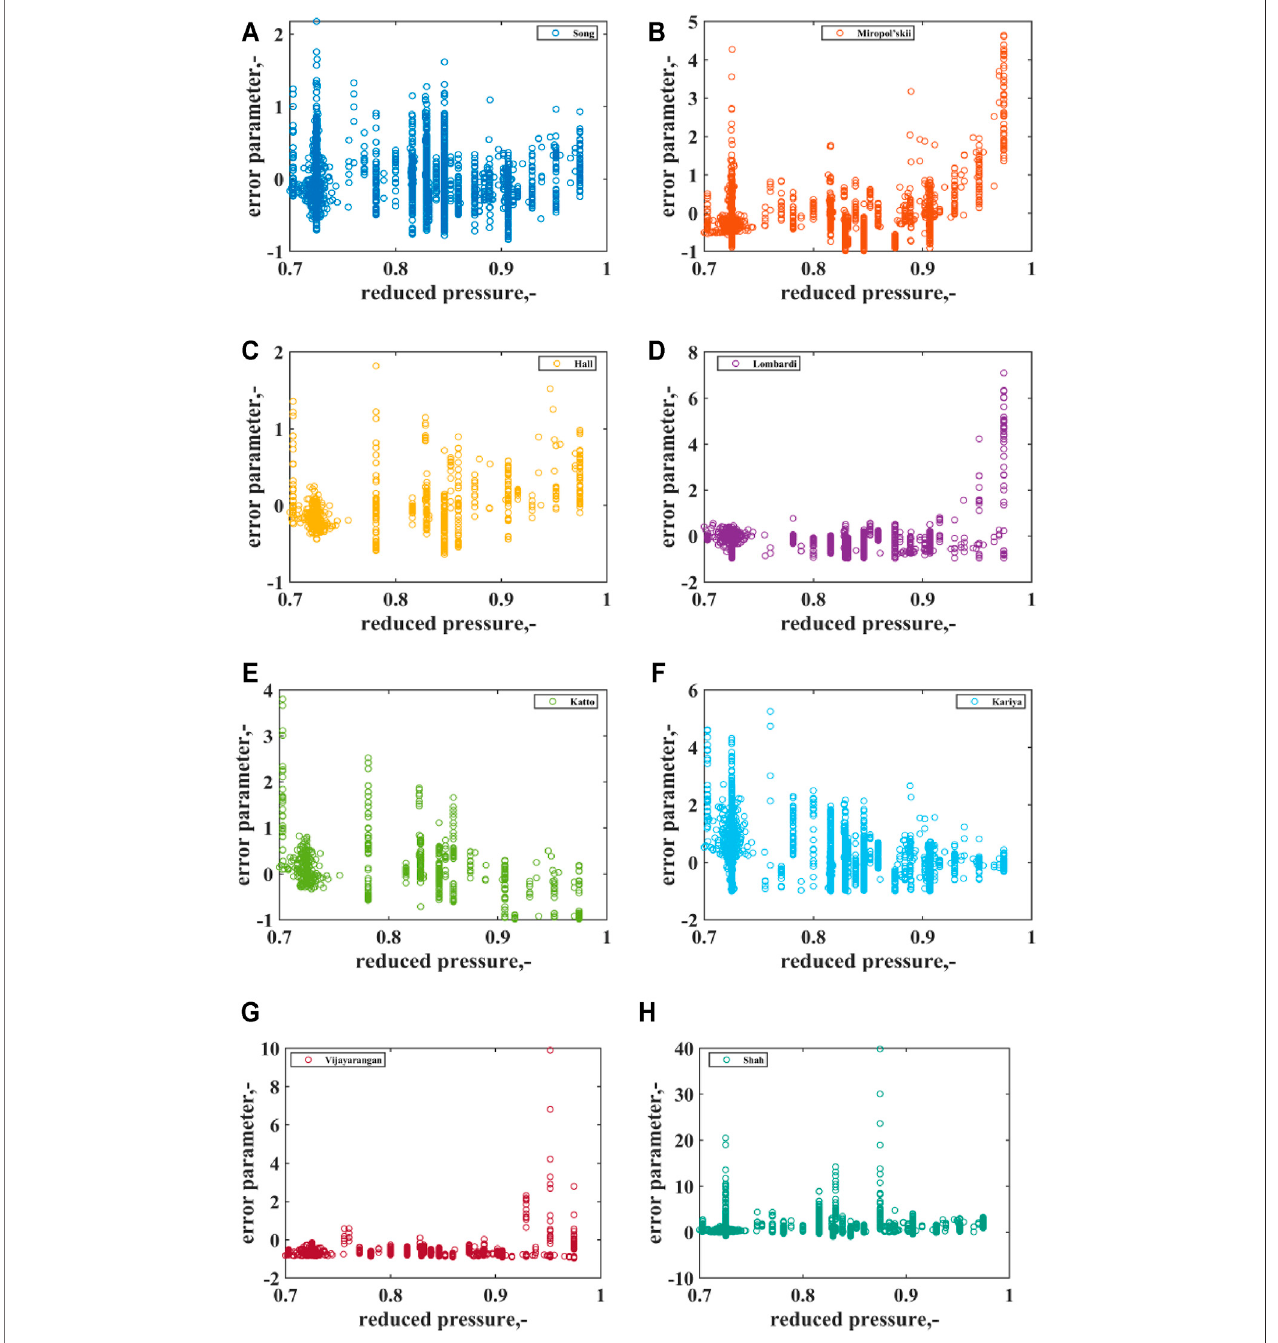
FIGURE 4 | Distribution of error parameters versus reduced pressure. (A) Song correlation (Song et al., 2021a). (B) Miropol ’ skii correlation (Miropol ’ skii and Shitsman, 1962). (C) Hall correlation (Hall and Mudawar, 2000). (D) Lombardi correlation (Lombardi, 1995). (E) Katto ’ s sublayer dryout model (Katto, 1992). (F) Kariya correlation Kariya et al., 2013). (G) Vijayarangan correlation (Vijayarangan et al., 2006). (H) Shah correlation (Vijayarangan et al., 2006).